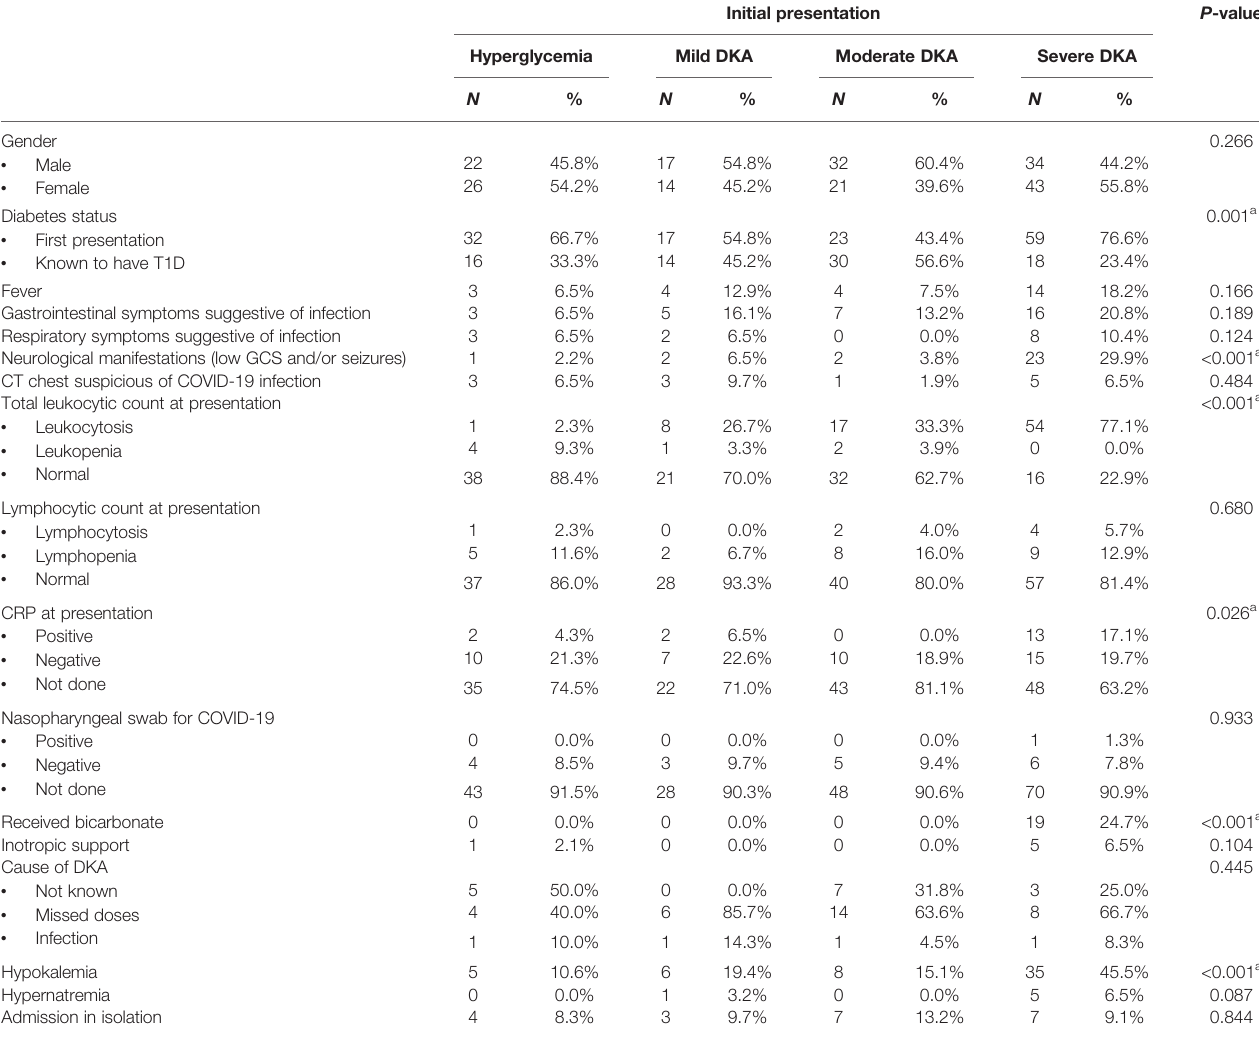
TABLE 3 | Association of the grades of severity of DKA and the enlisted variables in the second COVID-19 wave.